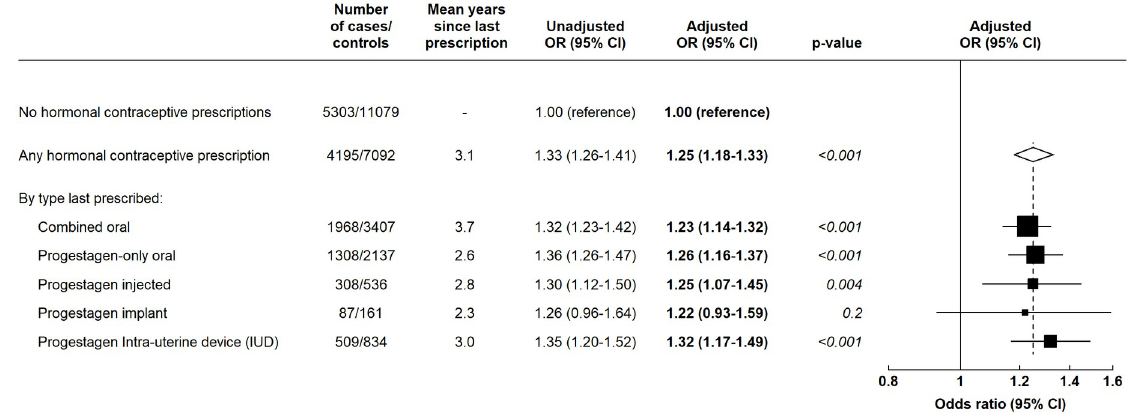
Fig 1. ORs and 95% CIs for breast cancer in women aged < 50 years with any versus no prescriptions for hormonal contraceptives by the last type prescribed. Data from the CPRD. Adjusted ORs are adjusted for time since last birth, number of recorded births, BMI, and alcohol intake. P values are based on the relevant Wald tests AU : AbbreviationlistshavebeencompiledforthoseusedinFigs 1 (cid:0) 6 : Pleaseverifythatallentriesarecorrect : . BMI, body mass index; CI, confidence interval; CPRD, Clinical Practice Research Datalink; IUD, intrauterine device; OR, odds ratio.